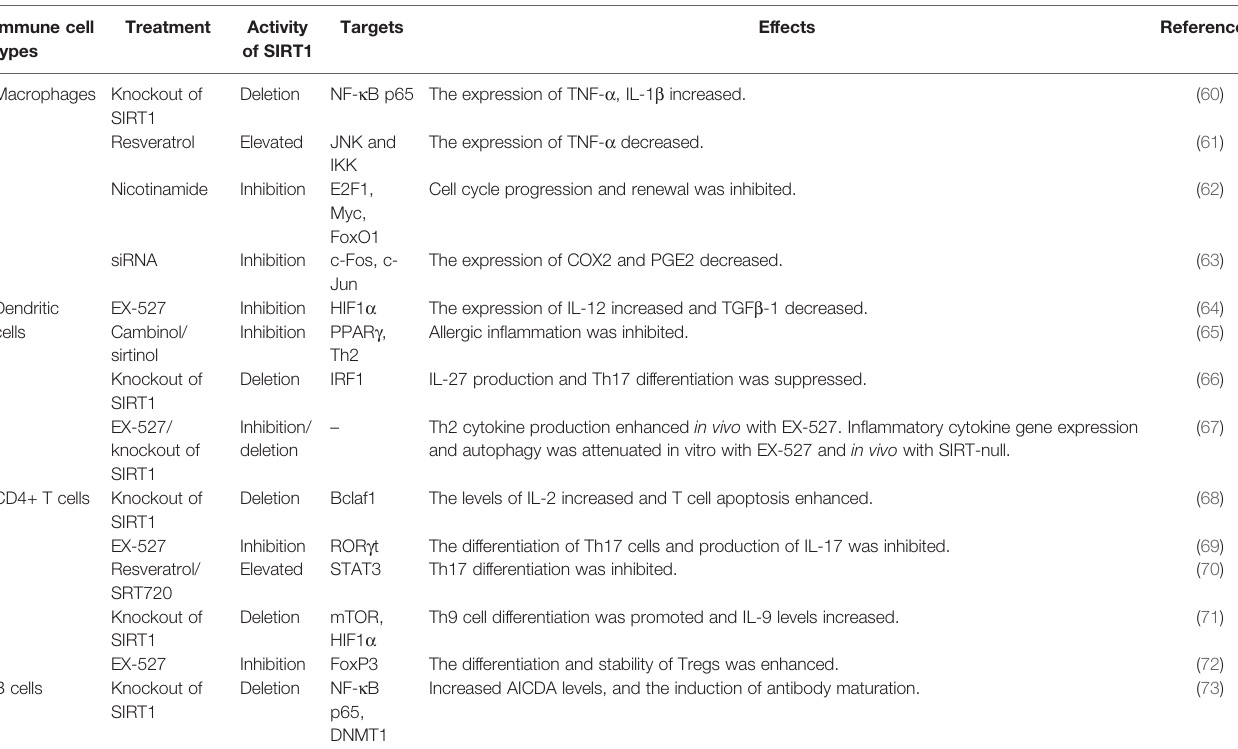
TABLE 2 | The Immunological Functions of